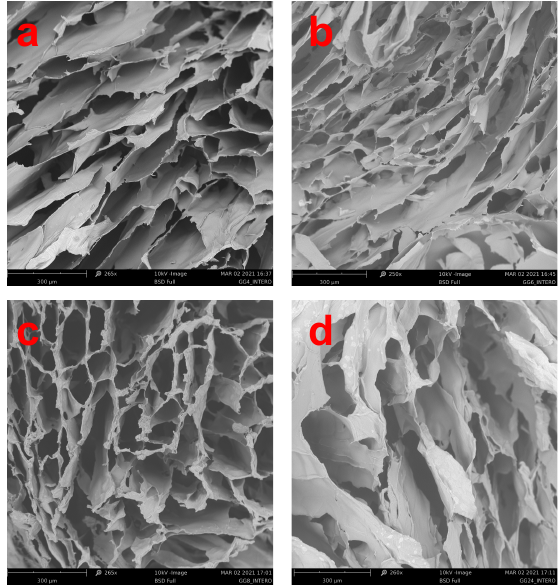
Figure 5. SEM images of freeze-dried hydrogel obtained by the ionotropic crosslinking of 5% w/v aqueous dispersion of GG 4 ( a ), GG 6 ( b ), GG 8 ( c ) and GG 24 ( d ).